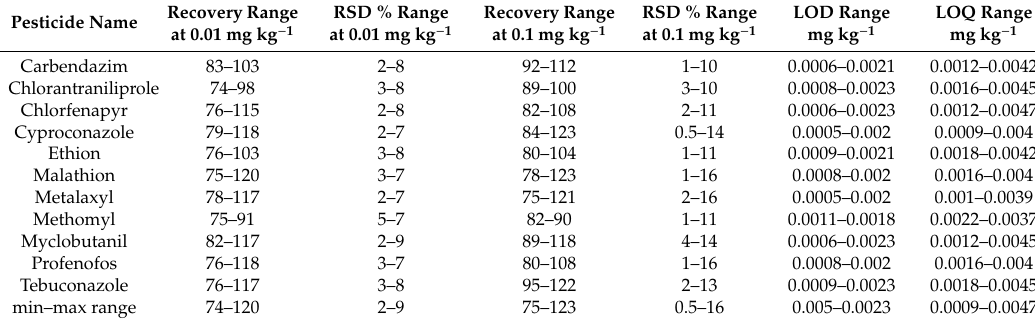
Table 1. Recovery, precision, and detection limit ranges for selected pesticides that exceeded the maximum residue levels (MRLs) in di ff erent commodities.